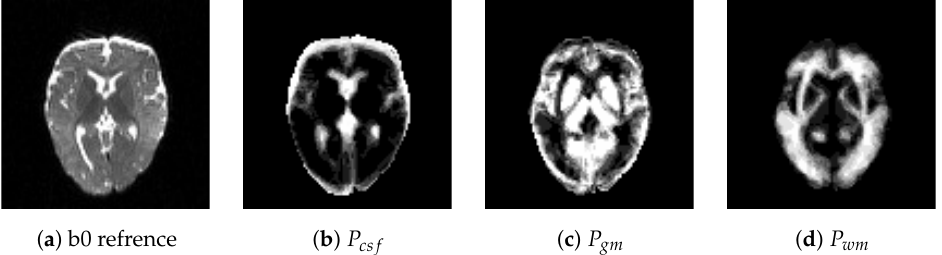
Figure 4. The shape prior probabilities estimated by the proposed adaptive shape model. ( a ) b0 reference image, ( b ) CSF prior probability, ( c ) GM prior probability, and ( d ) WM prior